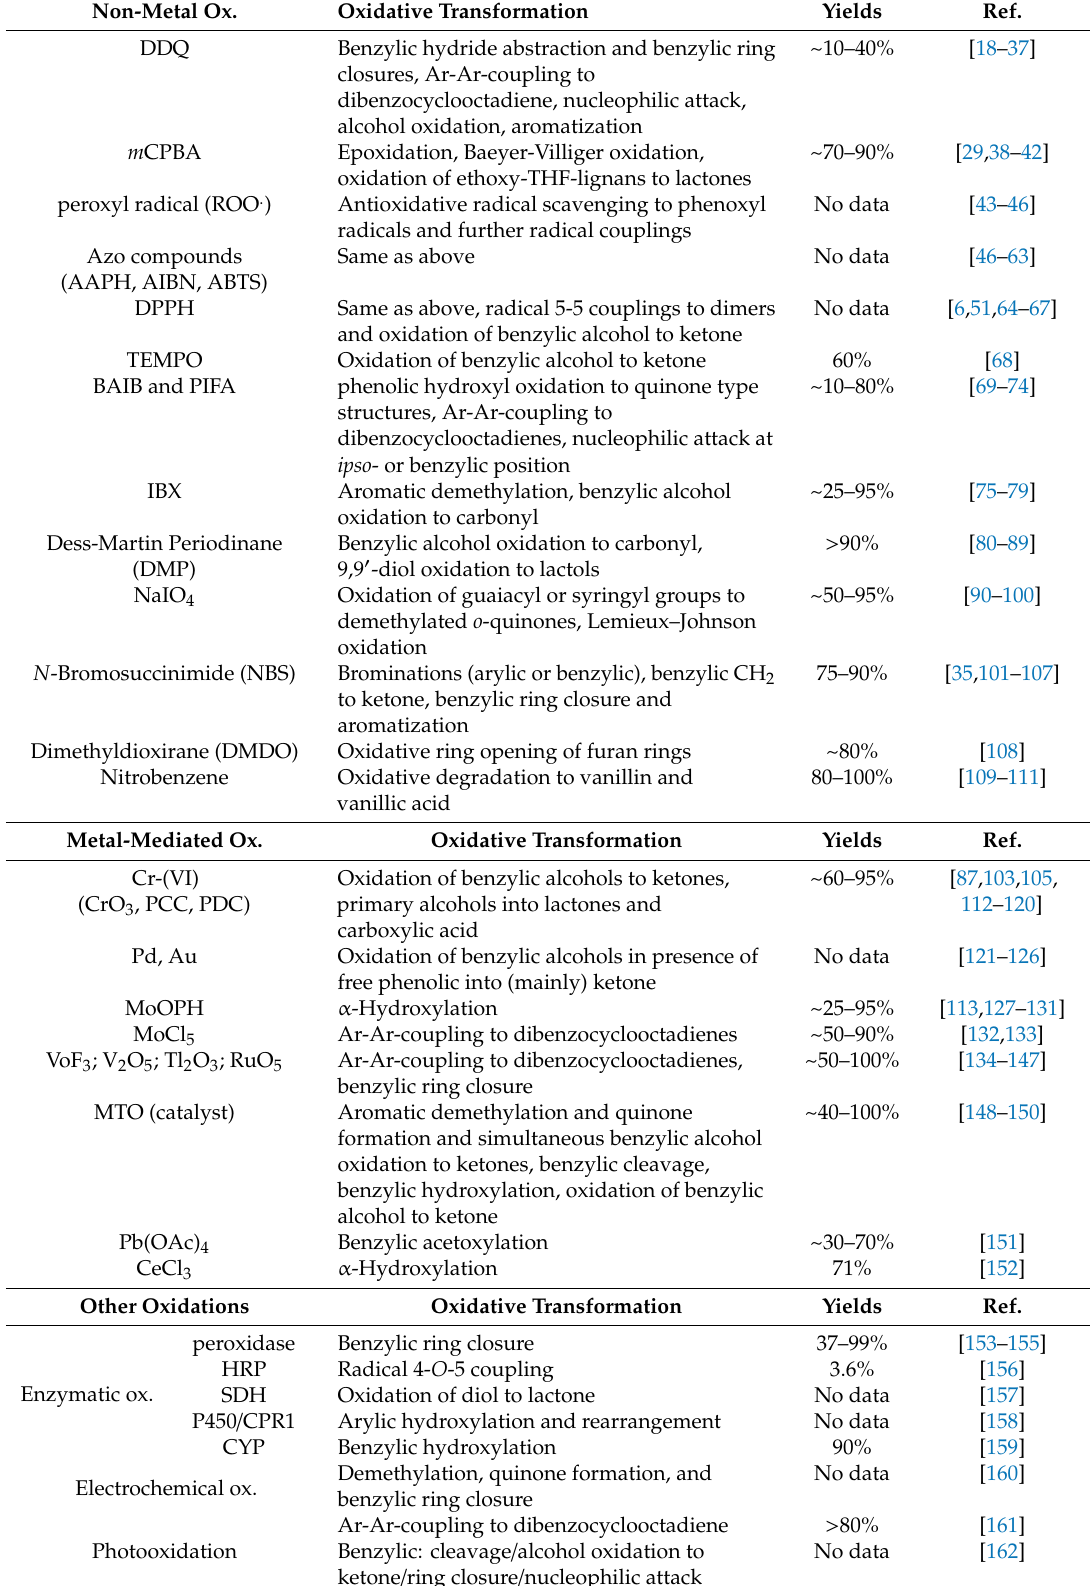
Table 1. Various methods for oxidative transformations of